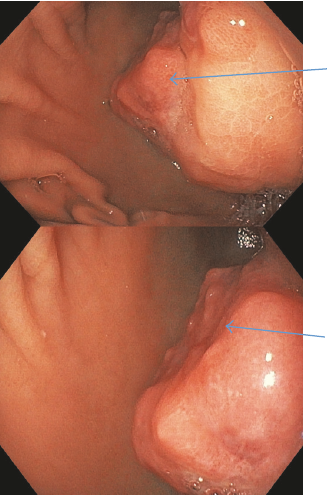
Figure 3: Endoscopic images showing ulcerative irregular mass emerging from the distal antrum, near posterior wall of